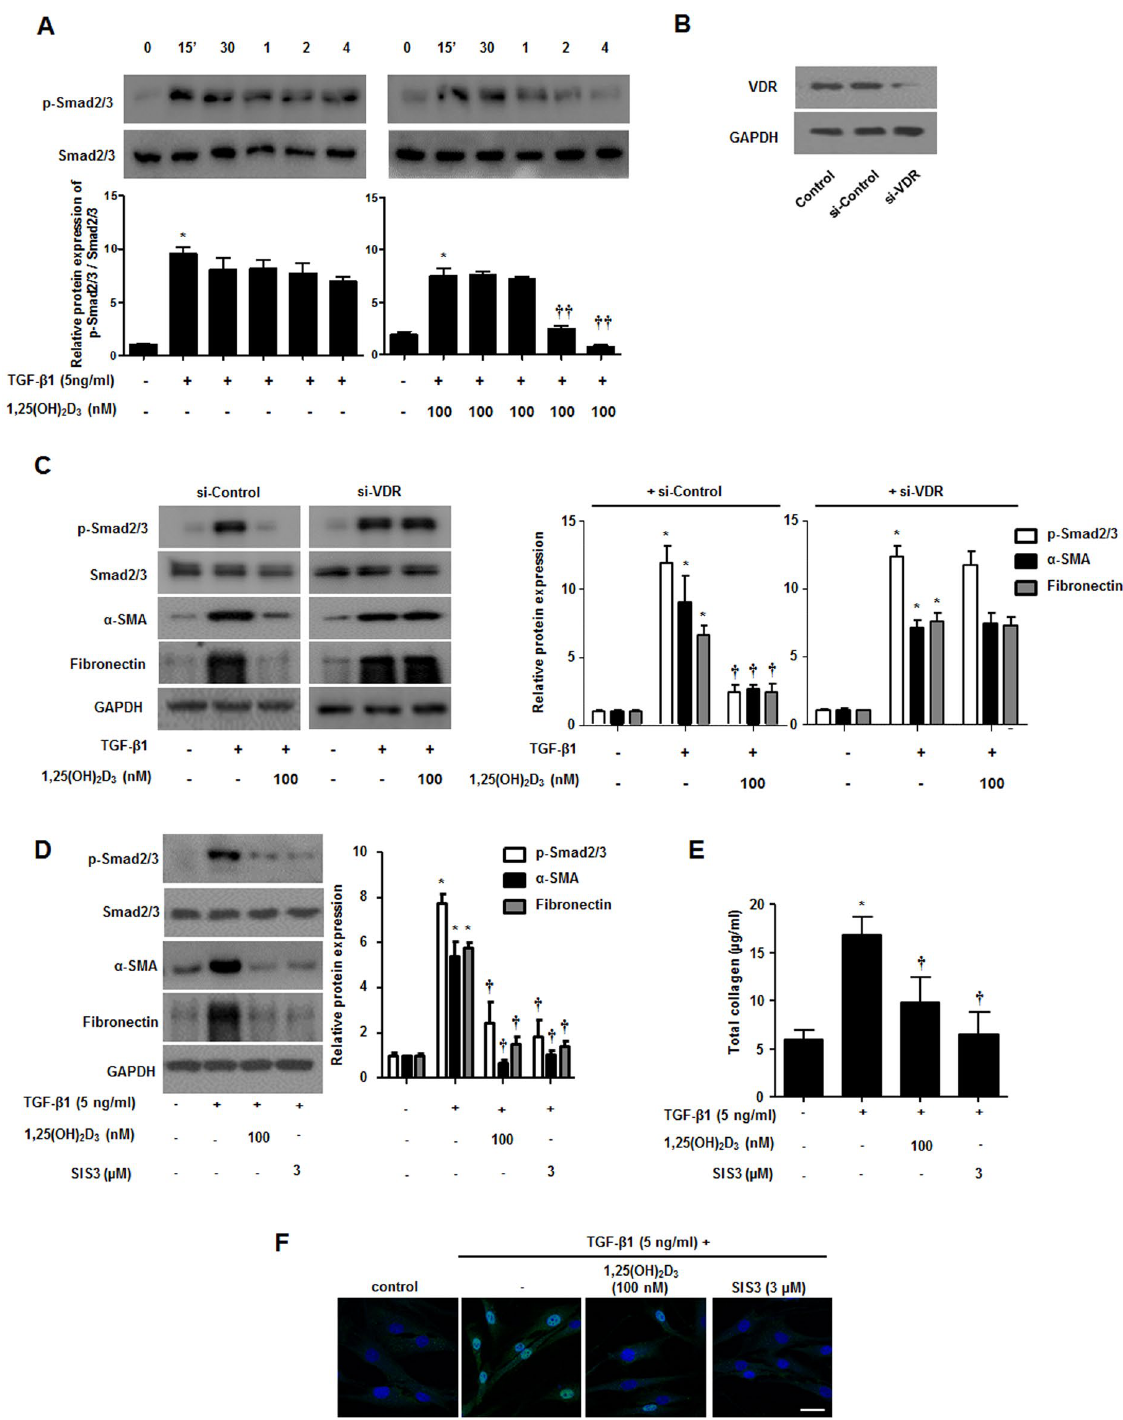
Figure 3. 1,25(OH) 2 D 3 inhibits phosphorylation of smad2/3 in nasal polyp-derived fibroblasts. Nasal polyp-derived fibroblasts were treated with TGF- β 1 and/or 1,25(OH) 2 D 3 up to 4 hours. ( A ) Expression levels of phosphorylated Smad2/3 were determined by Western blotting. ( B ) Specific VDR siRNA (10 nM) was transfected in NPDFs and the inhibitory effect of VDR siRNA was confirmed by Western blotting. ( C ) Transfected NPDFs with VDR siRNA were treated with or without 1,25(OH) 2 D 3 (100 nM) for 1 hour and cells were stimulated with TGF- β 1 (5 ng/ml) for 4 hours and 72 hours. Phosphorylated Smad2/3 and α -SMA, fibronectin was determined by Western blotting. ( D ) NPDFs were treated with TGF- β 1 (5 ng/ml) and/or levels of the housekeeping GAPDH protein were utilized as internal controls. A representative experiment and quantitative determination of protein levels are shown. ( E ) The amount of total soluble collagen in